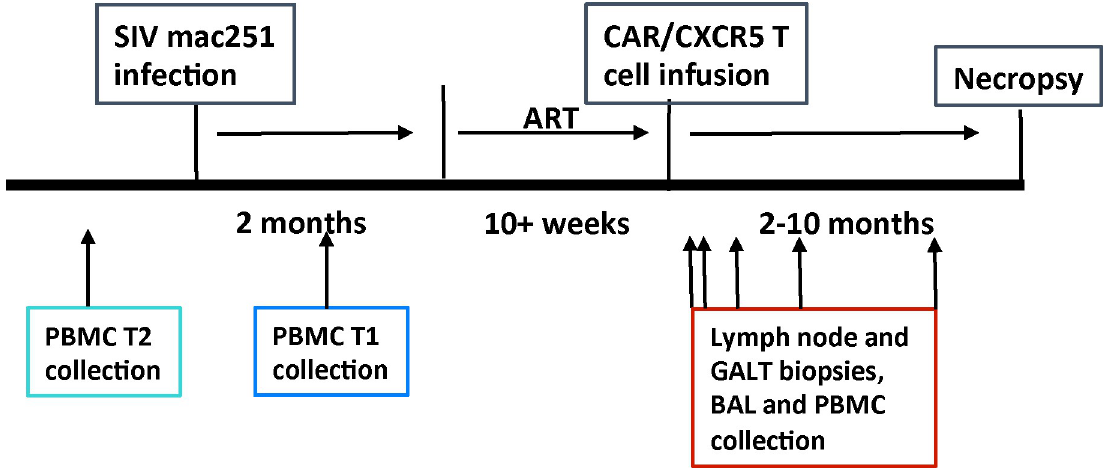
Fig 3. A timeline of the Rhesus macaque pilot studies. Animals were infected with SIV mac251 and ART suppressed. Cells were collected for transduction either post-infection (T1) or pre-infection (T2). ART was interrupted at the time of CAR/CXCR5 cell infusion. Blood and tissue samples were collected at indicated intervals